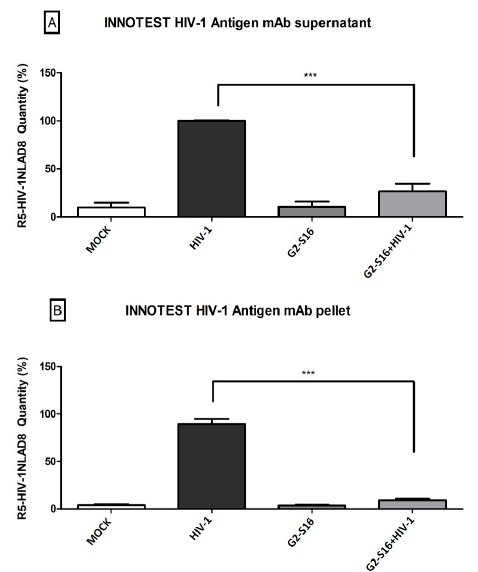
Figure 4. G2-S16 decreases the HIV-1 amount reaching T cells from infected MDMs. MDMs treated with G2-S16 and infected with 6 ng/µL of HIV-1 per 1 × 10 6 cells for 2 h were co-cultured with isolated T CD4/CD8 for 48 h. After incubation with T cells, ( A ) supernatant and ( B ) pellets were isolated and titrated by HIV-1 p24 enzyme immunoassay (Elisa kit INNOTEST HIV-1 Antigen mAb). Mock cells were used as the non-treated control. The mean values (mean ± SD) of three inde- pendent experiments are shown (*** p < 0.001). In addition, in order to verify the infectivity of HIV-1 in these T cells, a titration in TZM.bl was performed (Figure 5). In this analysis, we observed that T lymphocytes treated with G2-S16 dendrimer carried just 20% of the infective viral particles that reached them from MDMs. Thus, this means that G2- S16 dendrimer is capable of not only mini- mizing the number of infectious viral particles that reach T CD4/CD8 cells, but also elim- inating 80% of their infectivity in vitro.